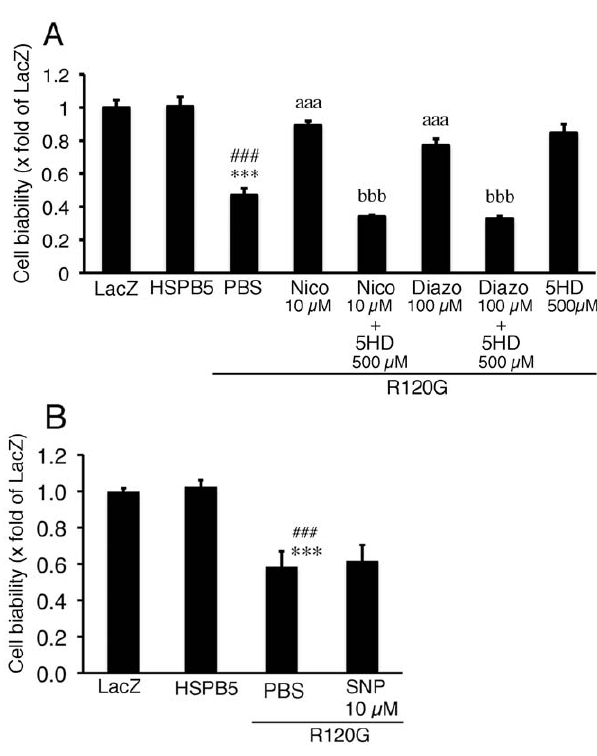
Figure 4. Cell viability in cardiomyocytes expressing R120G. (A) Protective effects of 10 m M Nico or 100 m M diazoxide (Diazo) on the cellular viability was inhibited by co-treatment with 500 m M 5- hydroxydecanoate (5HD). (B) No detectable effect on the cellular viability was seen by treatment with 10 m M sodium nitroprusside (SNP). Values are the x-fold increase relative to the cardiomyocyte infected with the LacZ whose values are arbitrarily set to 1. *** p , 0.001, vs. the cardiomyocytes infected with LacZ (LacZ), ### p , 0.001, vs. the cardiomyocytes infected with wild-type HSPB5 (HSPB5), aaa p , 0.001 vs. cardiomyocytes infected with R120G treated with PBS, and bbb p , 0.001 vs. cardiomyocytes infected with R120G treated with 10 m M Nico or 100 m M Diazo